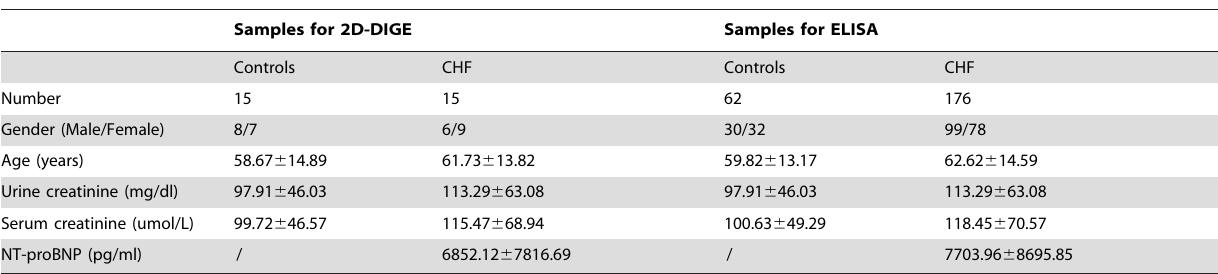
Table 1. Clinical data for subjects in the study.